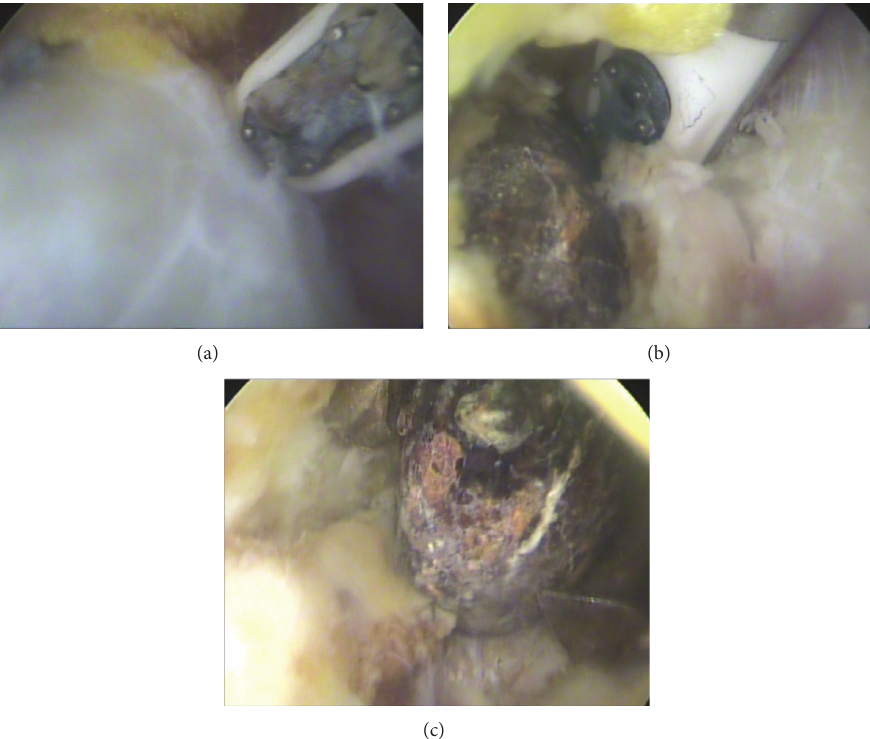
Figure 2: Sequence of events of the bullet extraction: (a) dissection around the bullet which is encapsulated in a fibrous scar, (b) removing of the fibrous scar around the bullet, and (c) bullet extraction with a pincer to